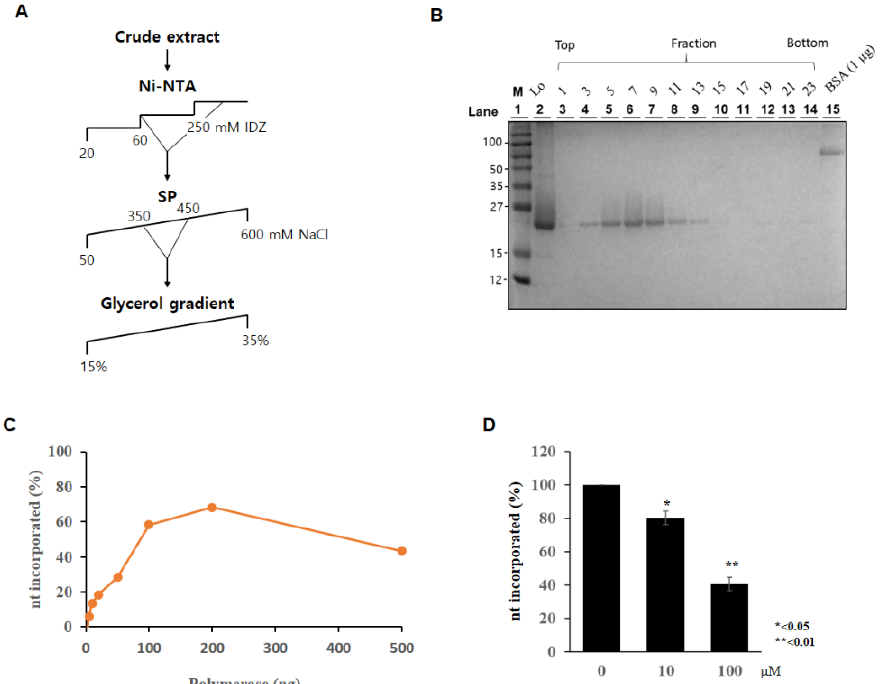
Figure 5. Pentagastrin inhibits Asfv PolX activity. ( A ) Schematic illustration of recombinant PolX purification. Ni-NTA, Ni 2+ -nitrilotriacetic acid affinity; SP, SP column chromatography; IDZ, imidazole. Glycerol gradient indicates the final purification procedure using glycerol gradient sedimentation. ( B ) Twelve fractions collected from glycerol gradient sedimentation were analyzed in a 15% SDS-PAGE and then the gel was stained with Coomassie Brilliant Blue R-250. Lo, Load. Molecular mass markers are indicated in kDa. ( C ) Polymerase activity was determined by measuring nt incorporation using indicated amounts of purified AsfvPolX protein. ( D ) Pentagastrin was mixed with 100 ng of ASFV PolX for 10 min and polymerase activities were measured as described in Materials and